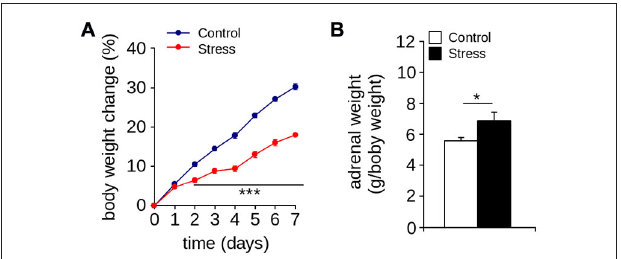
FIGURE 1 | Stress markers. (A) Body weight gain ( ∗∗∗ p < 0.001; Bonferroni post hoc test; n = 8 per group). (B) Adrenal weight of control and stressed animals was measured one day after the stress protocol ( ∗ p < 0.05; Mann-Whitney U-test; n = 6 per group). Values are mean ±